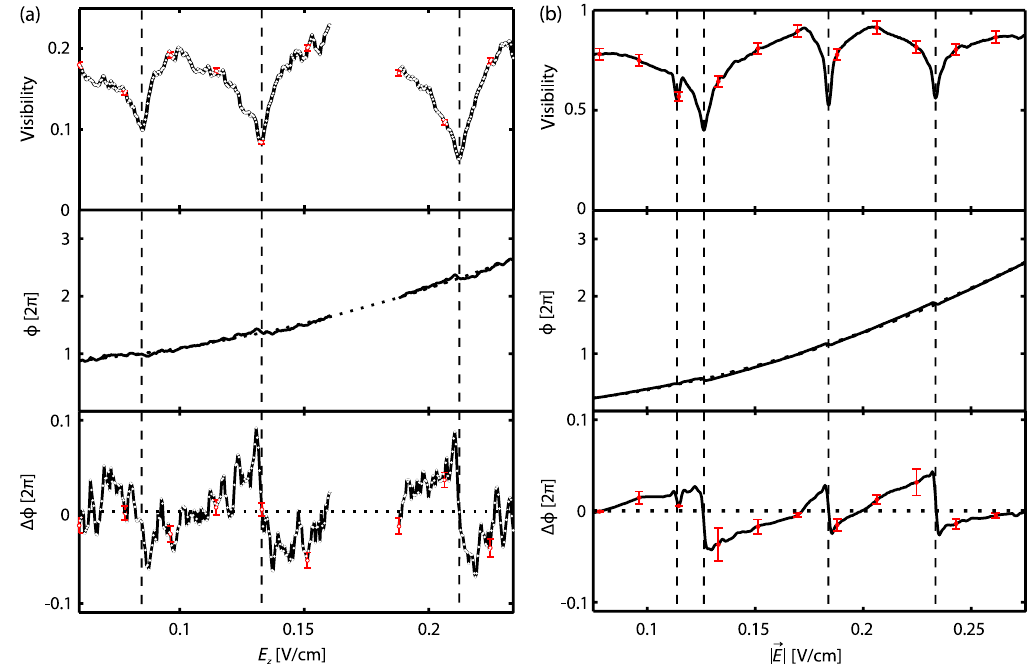
FIG. 5. Visibility and phase obtained from fits to (a) the measured and (b) the simulated Ramsey spectra versus the electric field. Note that the experimental spectra are plotted versus the calibrated component of the electric field E total electric field j ~E j . The uppermost panels show the visibility, the middle panel shows the phase of the Ramsey fringes (solid line) and a quadratic fit to the data (dotted line), and the lower panels show the difference of the measured phase from the pure quadratic behavior. Some example error bars are plotted, denoting the standard deviation of the fit